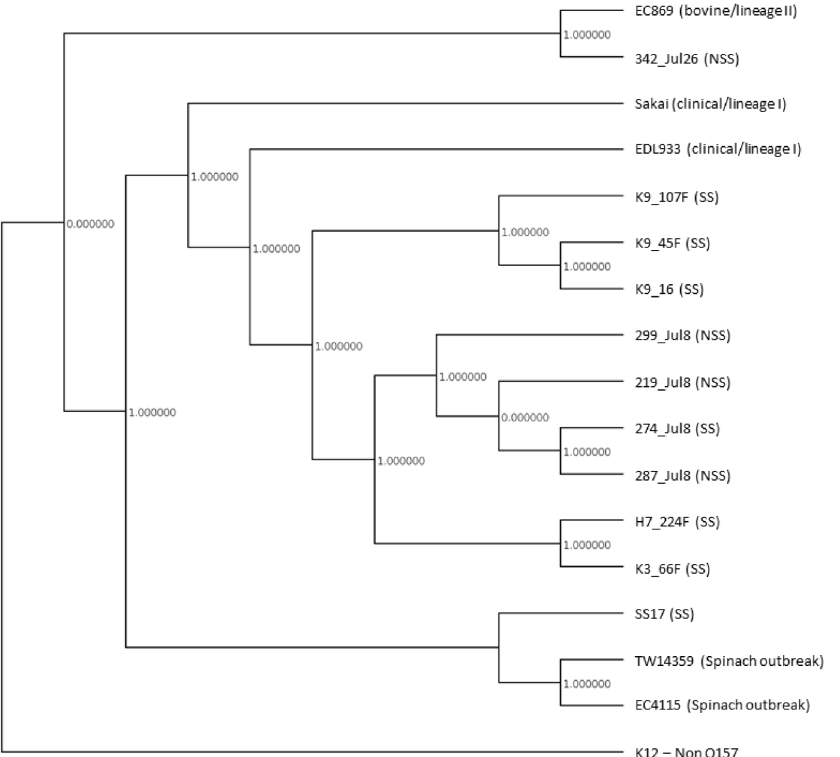
Fig 4. A reference free, pan-genomic comparison of super-shedding (SS; n = 6), low-shedding isolates (NSS; n = 4) and reference strains EC869 (GCA_000172035.1), Sakai (NC_002695),